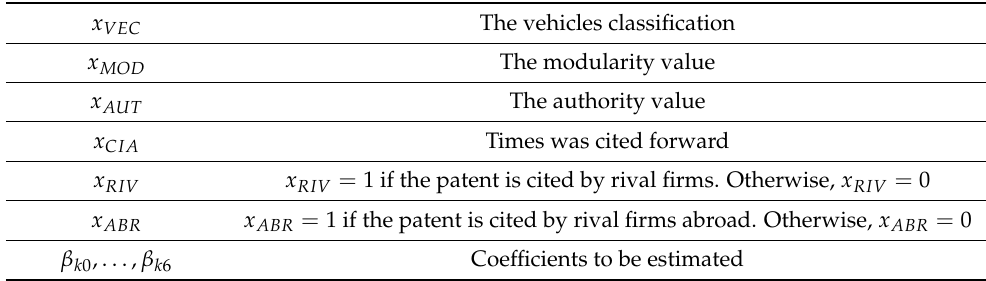
Table 3. Multinomial logistic regression model notation. x